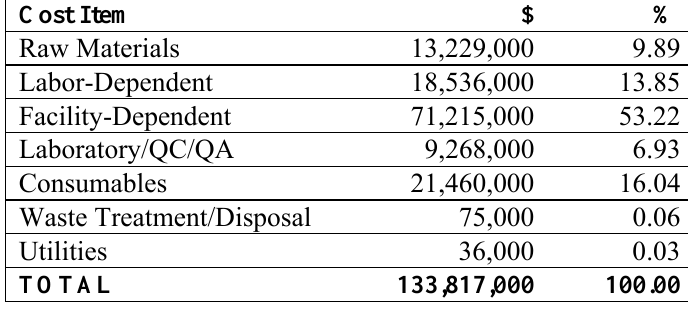
Table 4. Operating Cost Summary (Year 2013 prices in US $).